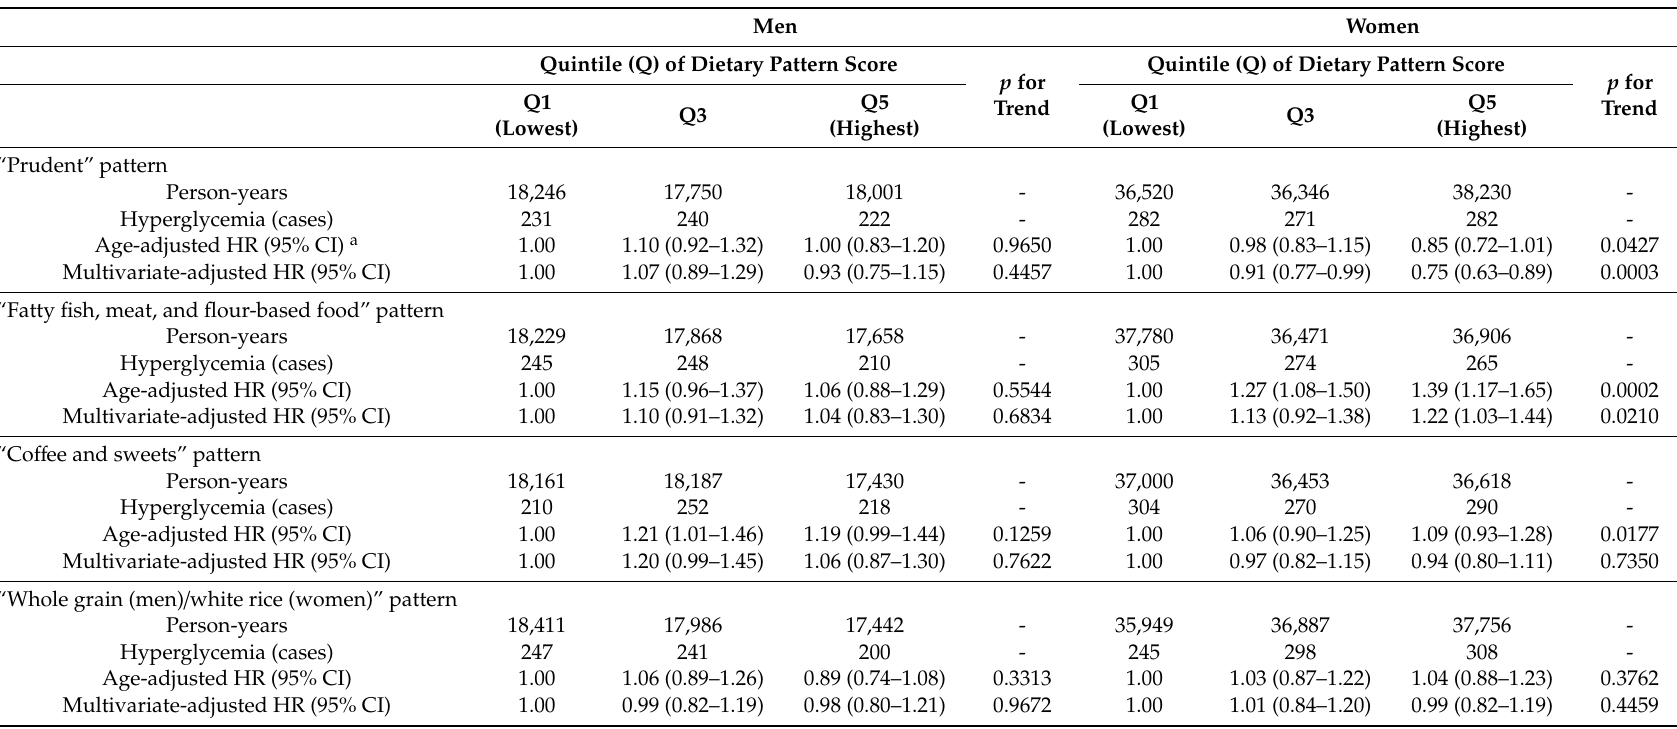
Table 6. Adjusted hazard ratios (95% confidence intervals) of hyperglycemia across quintiles of each dietary pattern score in the middle-aged Korean adults, the KoGES-HEXA